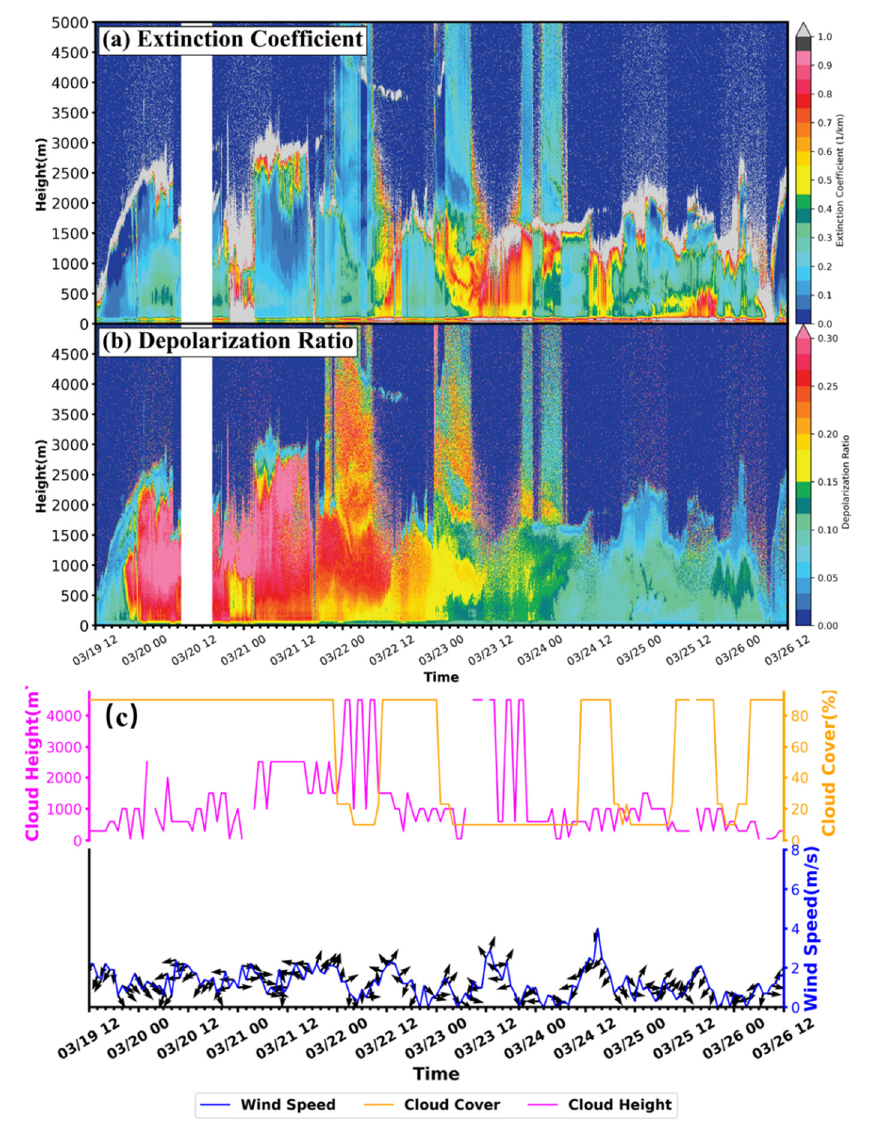
Figure 3. The extinction coefficients ( a ) and depolarization ratios ( b ) measured by ground lidar and near surface meteorological parameters ( c ) at Chengdu from 19 March to 26 March